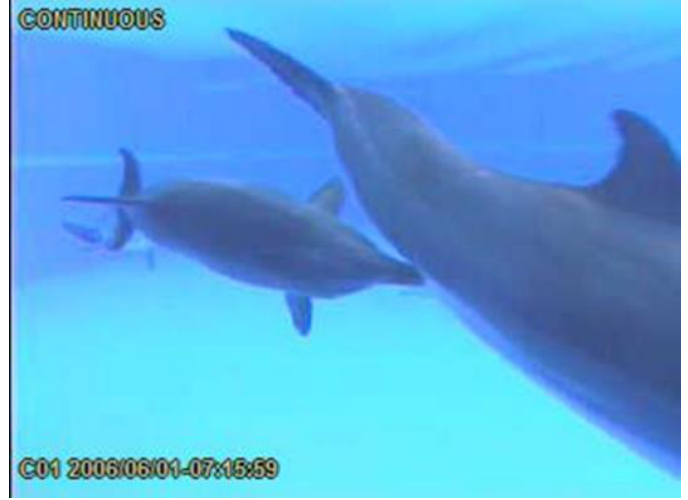
Figure 12 . Goose (GOS) of animal 1 by animal